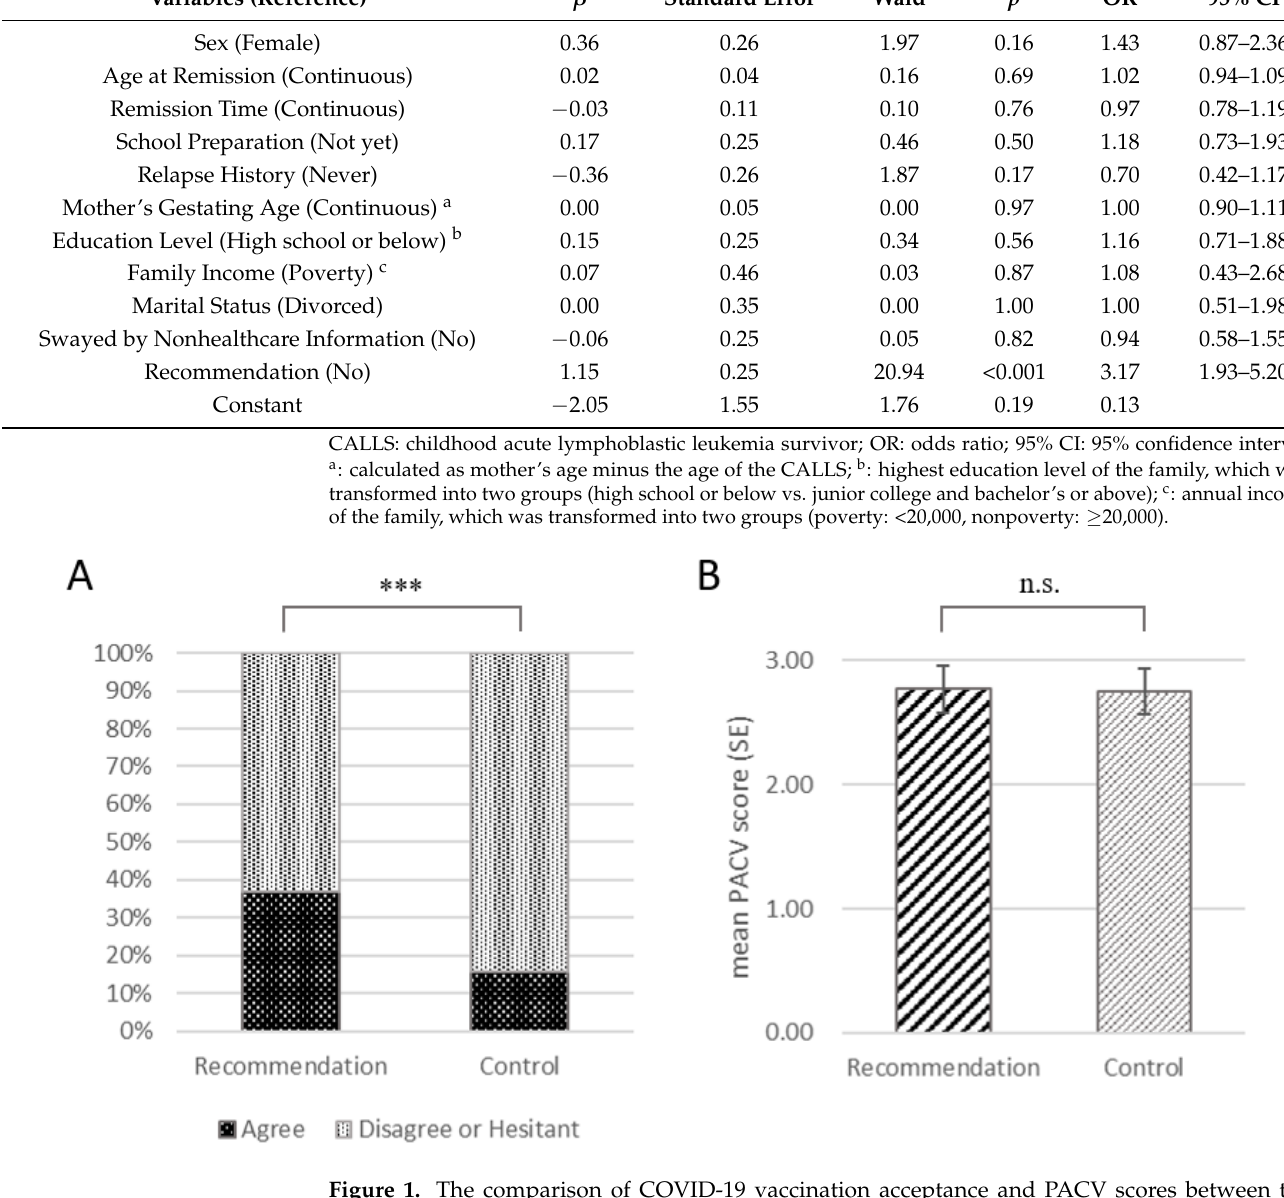
Figure 1. The comparison of COVID-19 vaccination acceptance and PACV scores between the recommendation group and control group (both in matched samples). ( A ), the willingness for vaccination in the recommendation group was significantly higher than in controls ( p < 0.001); ( B ), there was no significant difference in the mean PACV scores between the two groups. Notes: the “recom- mendation group” means parents who were recommended by the oncologists, and the “control group” means parents who did not receive recommendation from the oncologists. (*** p < 0.001; n.s.: